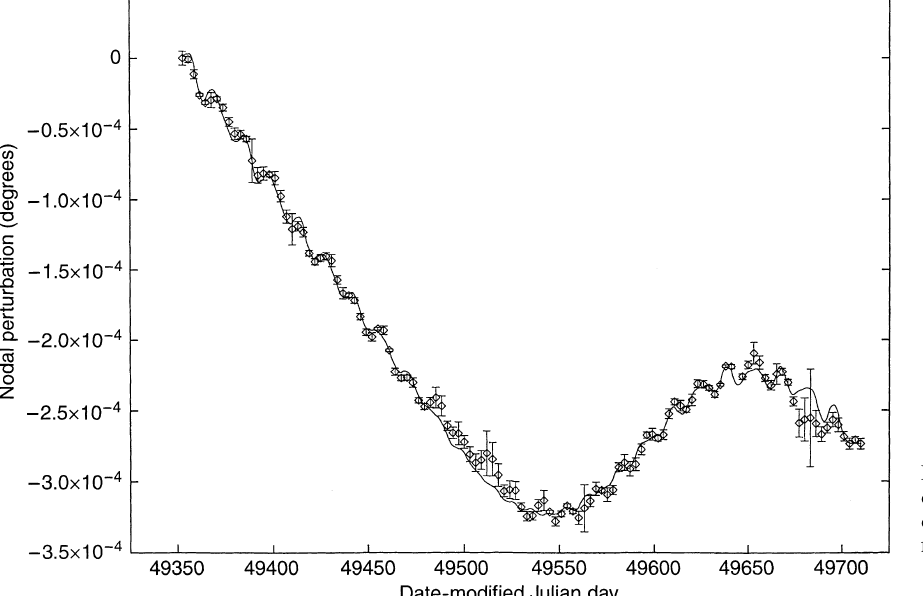
Fig 6. The change in right ascension of the ascending node of Stella due to ocean tides from the